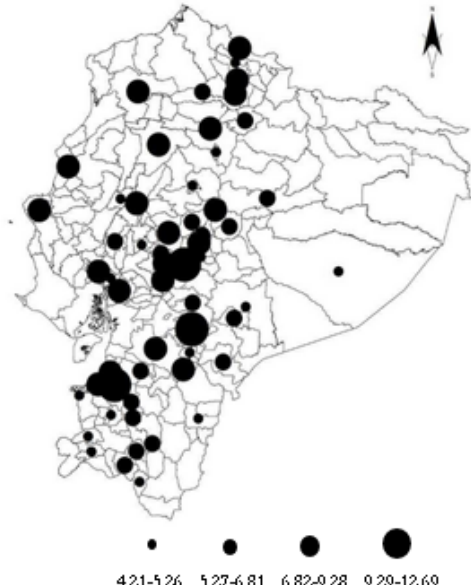
Figure 1: Average annual growth of productivity in the cantons of Ecuador: 1980 – 2010